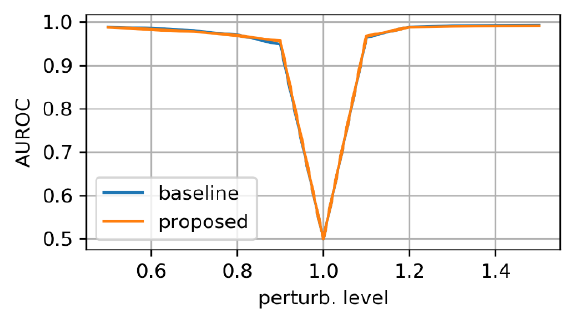
Figure 10. AuRoC performance for the baseline and proposed architecture when tested against mask translation in various directions. Training done on augmented dataset using the hinge loss in Equation (3).